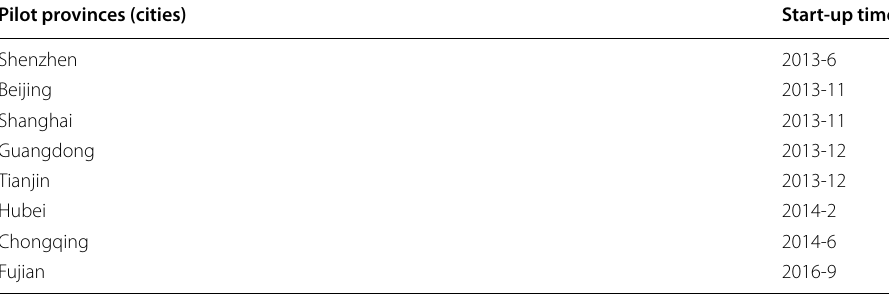
Table 1 Pilot provinces (cities) and start‑up times of their carbon emission trading Pilot provinces